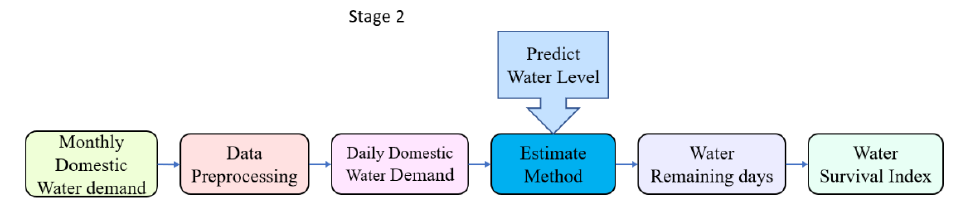
Figure 4. Second stage of the proposed